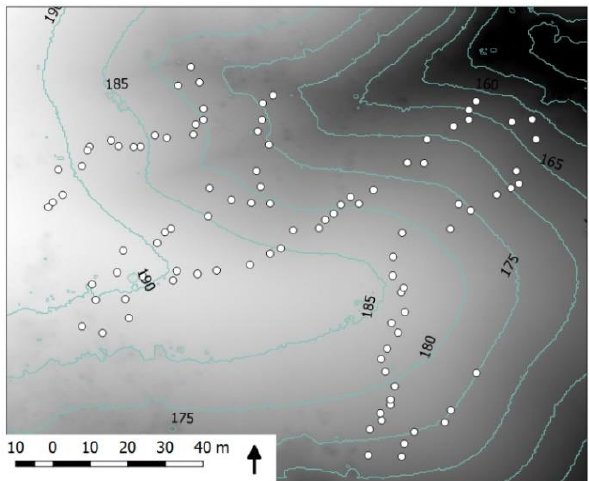
Figure 3. The Digital Terrain Model (DTM) derived by the photogrammetric point cloud. The positions of the sampled trees (n=100) are shown in white.